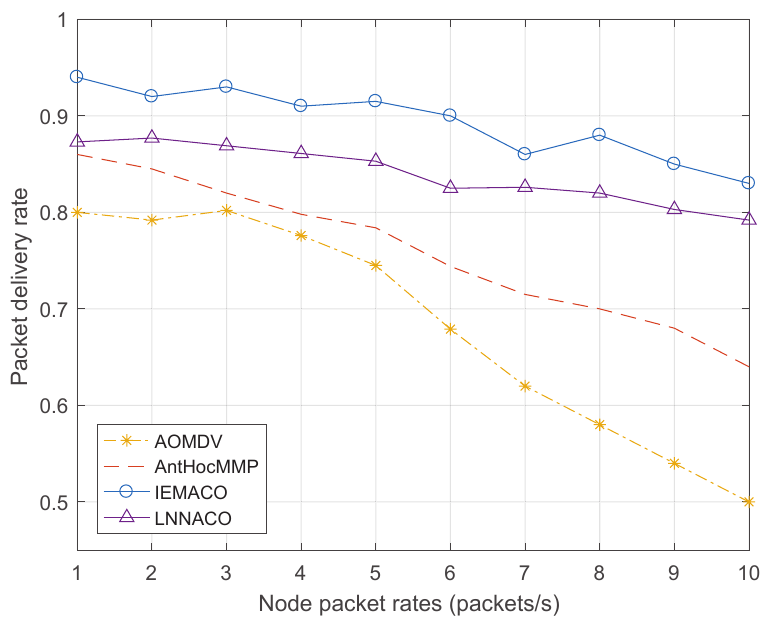
Figure 9. Packet delivery rate versus node packet rate.